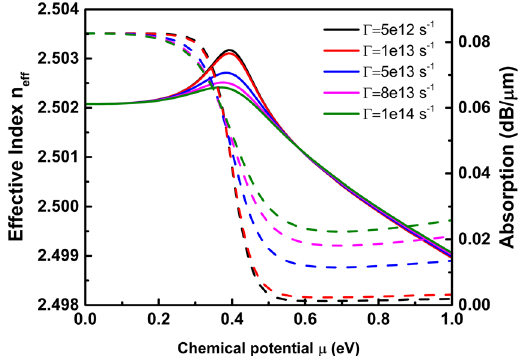
Figure 7. Simulated Re( n eff ) and absorption of the GOS modulator under different scattering rate Γ .